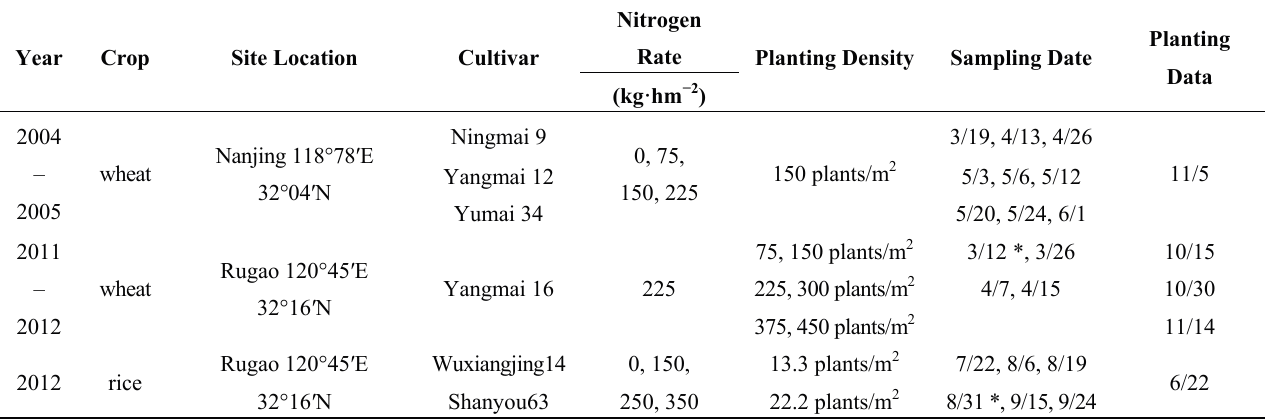
Table 5. Treatment and sampling information.